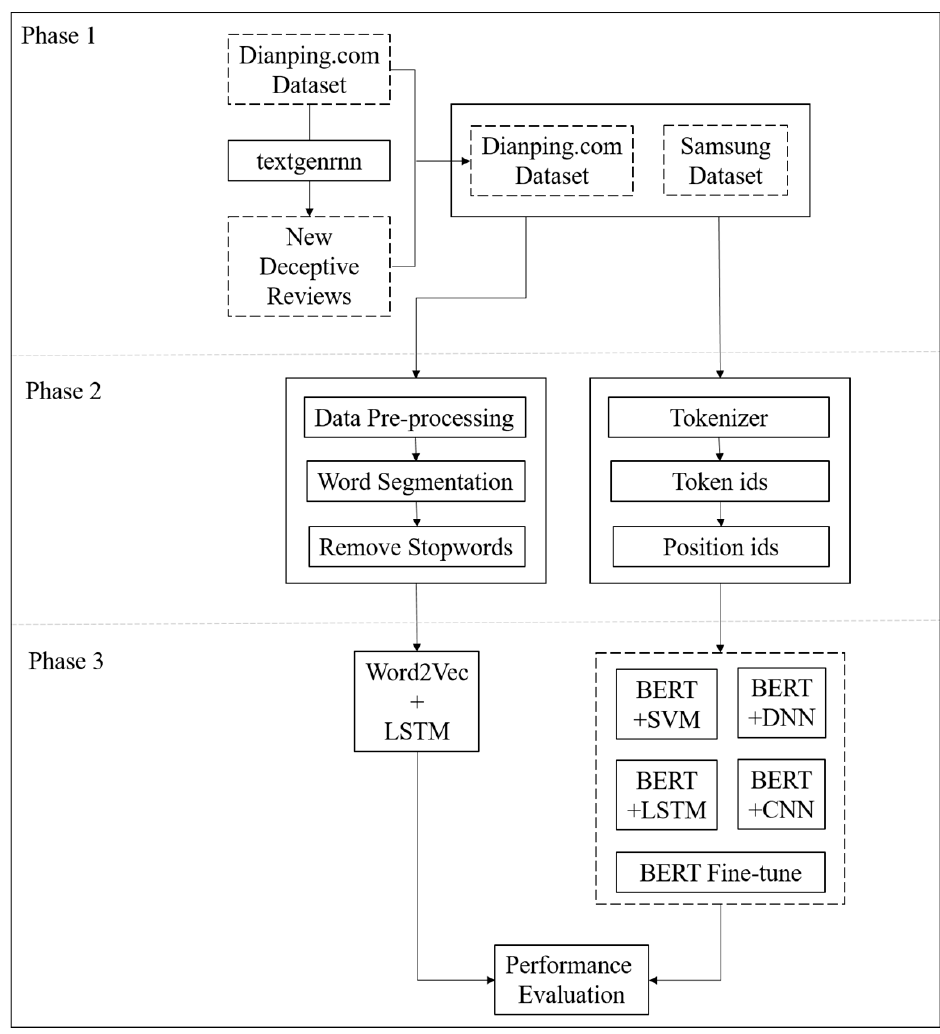
Figure 3. Research Framework.